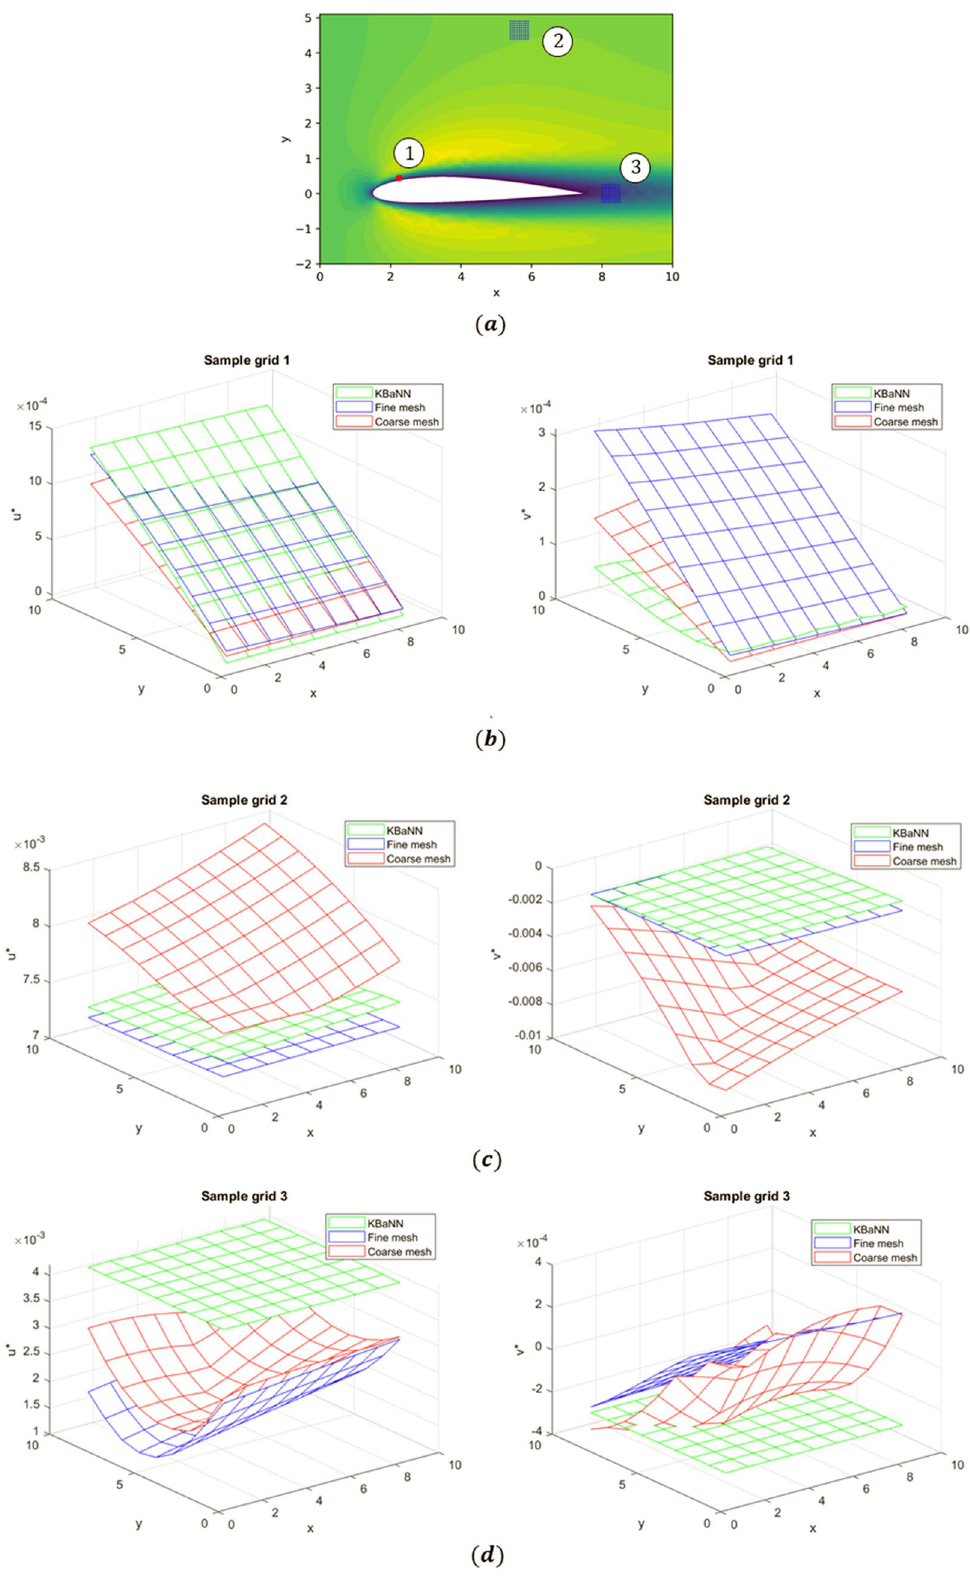
Figure 8. ( a ) the locations of the sample grids used to test the KBaNN. ( b – d ) A comparison of the predicted velocities in the sample grids from the KBaNN versus the fine mesh results. For comparison the velocities of the coarse mesh (which the KBaNN estimation is in part based on) are